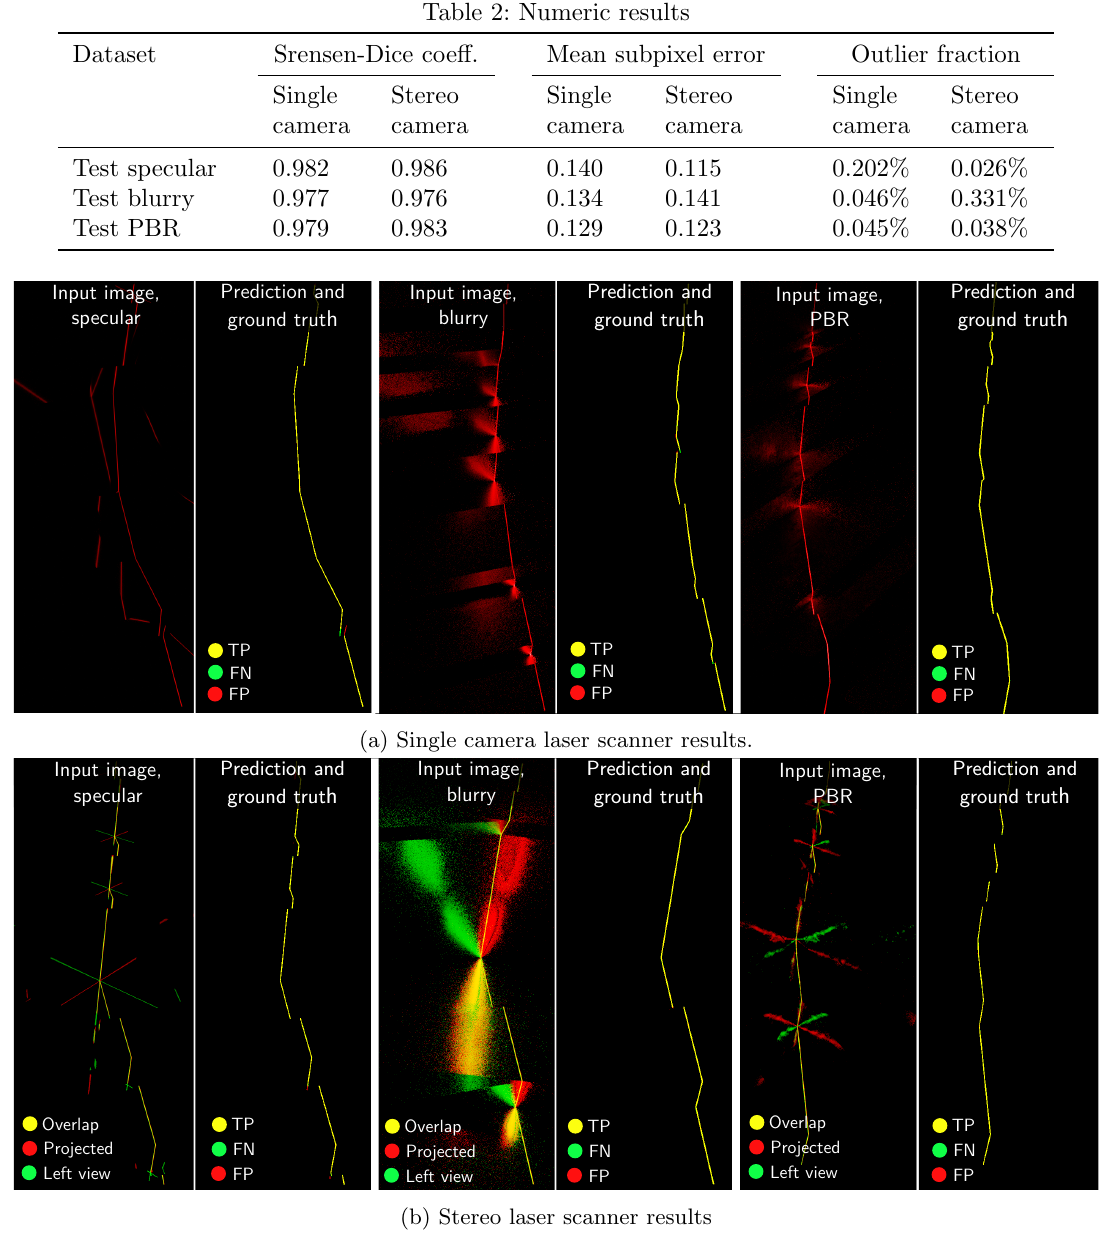
Figure 12: U-Net segmentation inputs, predictions, and ground truth. Each of the methods shows three pairs of input and predictions compared with ground truth. For each input-prediction pair, the input image is shown to the left, while the prediction compared with the ground truth is shown to the right. For the prediction-ground truth images, correct predictions are shown in yellow, while false positives are shown in red and false negatives in